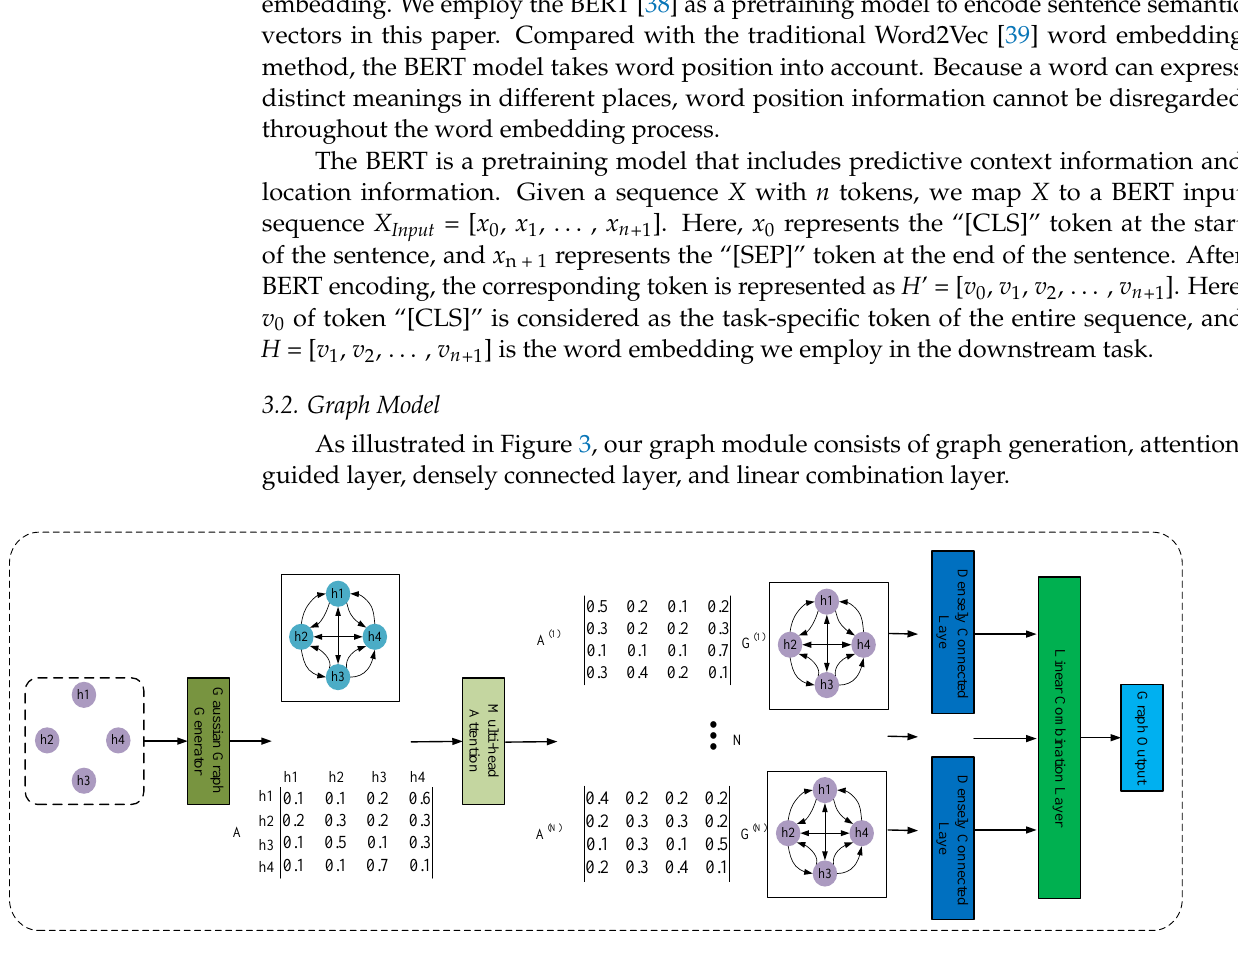
Figure 3. The graph module is shown with an example of four nodes and an adjacency matrix. The node embeddings and adjacency matrix are generated with KL divergence as inputs. Then, employing multi-head attention to construct N attention-guided adjacency matrices, the resulting matrices are fed into N separate densely connected layers, generating new representations. Finally, a linear combination layer is applied to integrate the outputs of the N different densely connected